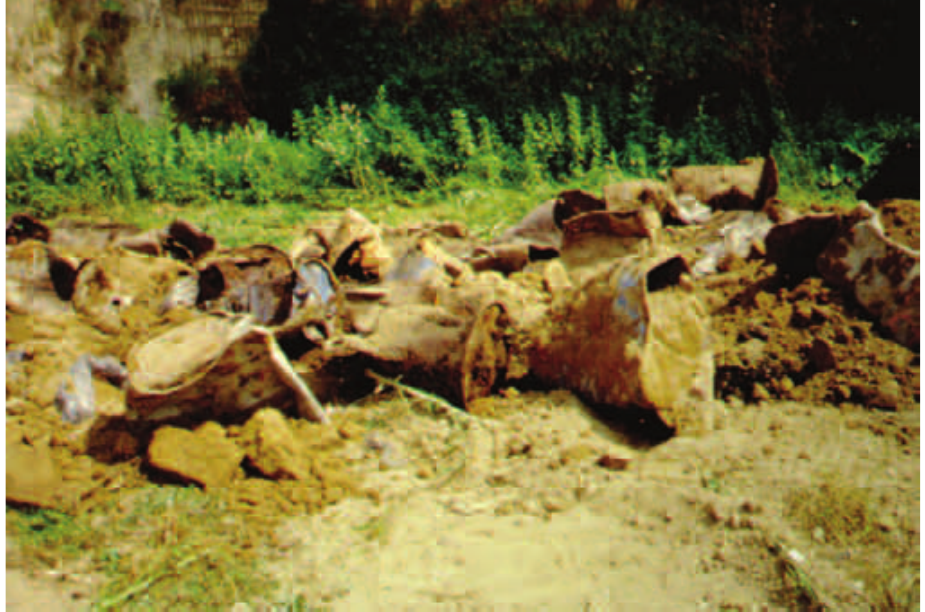
Photo 1. Some steel drums dug out after the first magnetometric survey performed at Riano Flaminio (north of Rome, Italy).